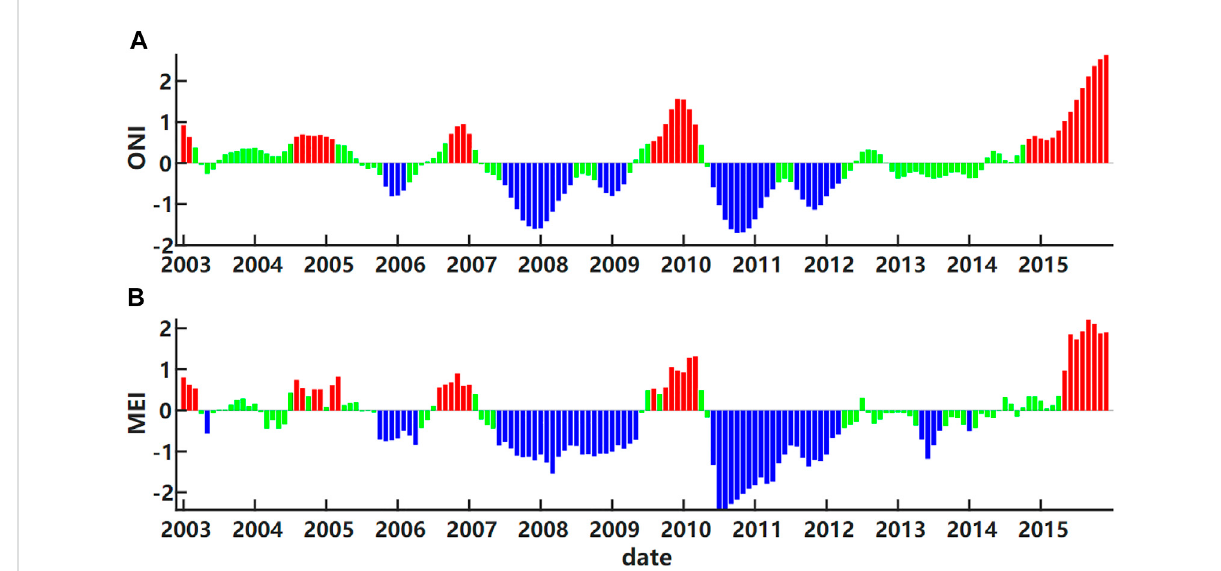
FIGURE 4 The (A) Oceanic Nino Index and (B) Multivariate ENSO Index time series, indicating the neutral (green bar), La Niña (blue bar), and El Niño (red bar)